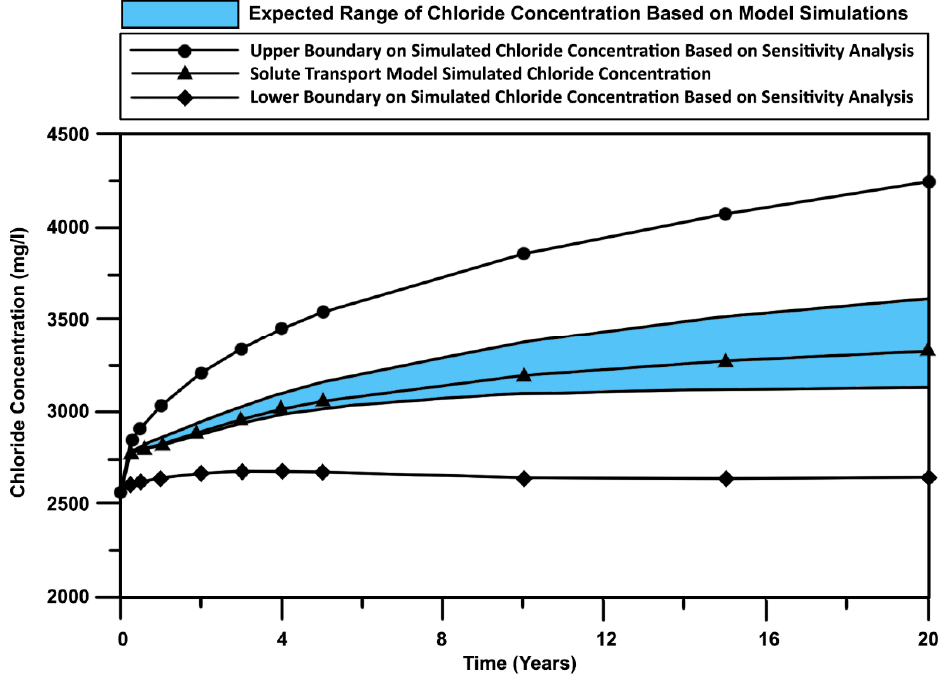
Figure 7. Original solute transport model for the South Collier County Wellfield based on a pumping rate of 41,667 m 3 /d (11 MGD) [32].